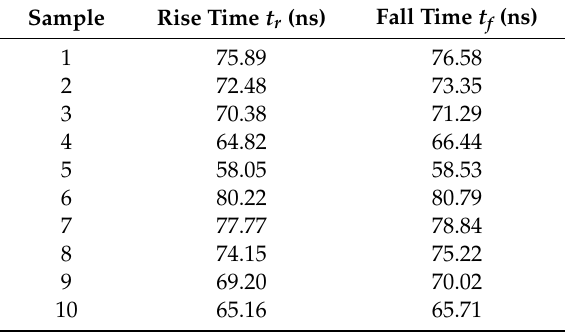
Figure 8. Exciting rectangular impulse and rising and falling edges in samples 1–10. ( a ) Samples 1–5; ( b ) samples 6–10. Table 4. Rising and falling edge times in samples